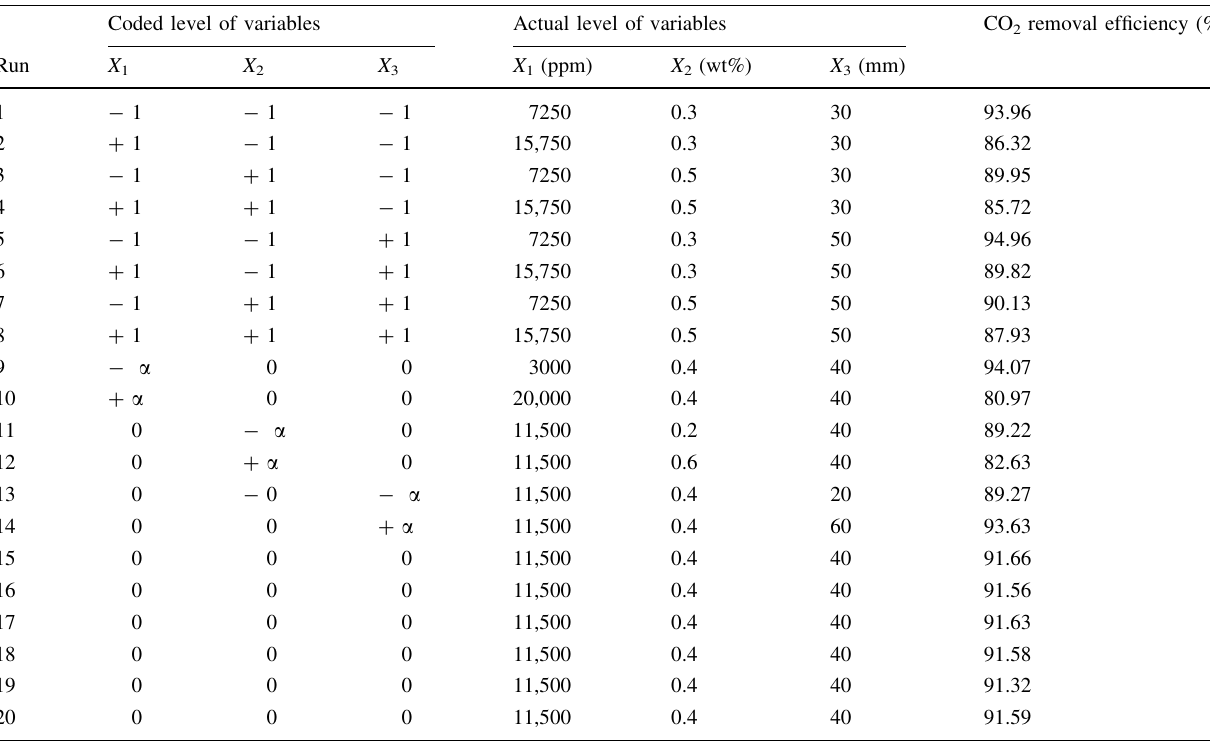
Table 3 Experimental design matrix and results